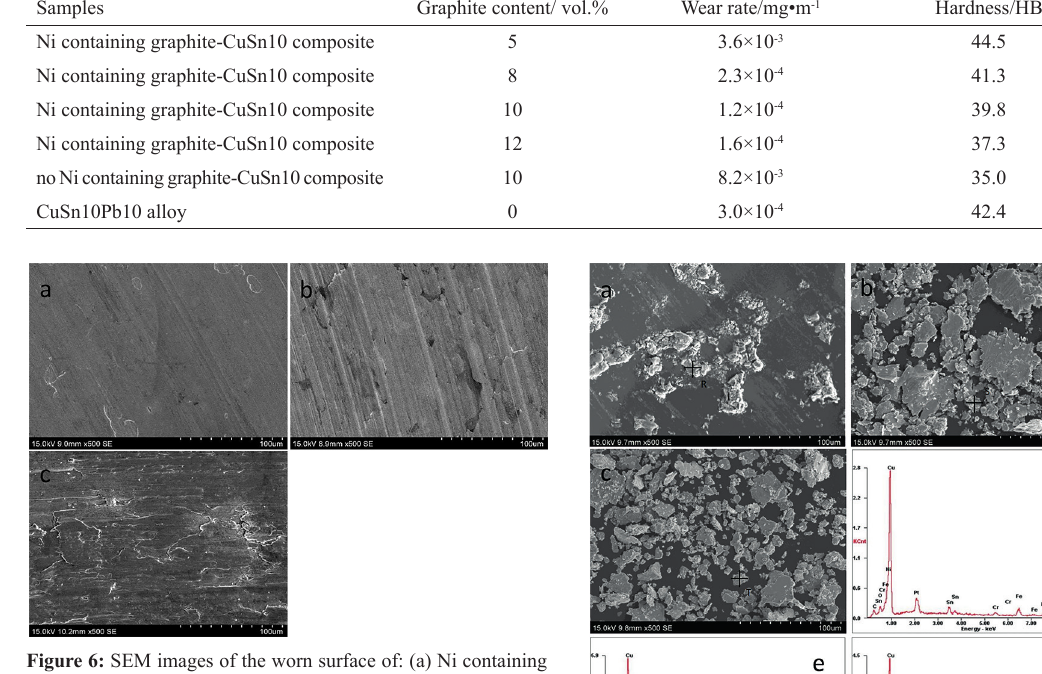
Table 1: Hardness and wear rate of graphite-CuSn10 composites and CuSn10Pb10 alloy. Samples Graphite content/ vol.%